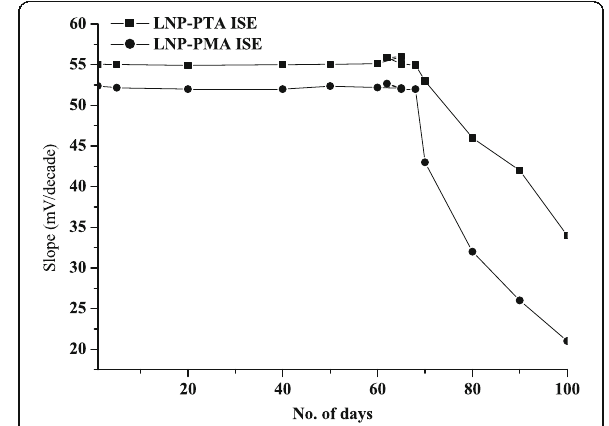
Fig. 8 Life time of LNP-PTA and LNP-PMA